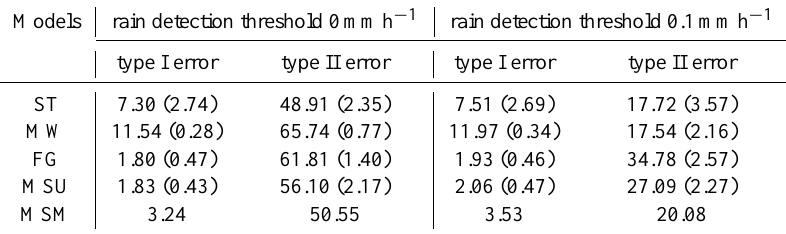
Table 3. Classification performances for dataset 2 (non-stationary case). Same format than in Table 2. Note that no model parameters could be fitted for the MSU algorithm on channels 2 and